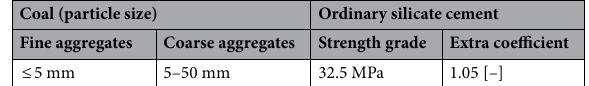
Table 5. Main raw material parameters for simulated coal walls.